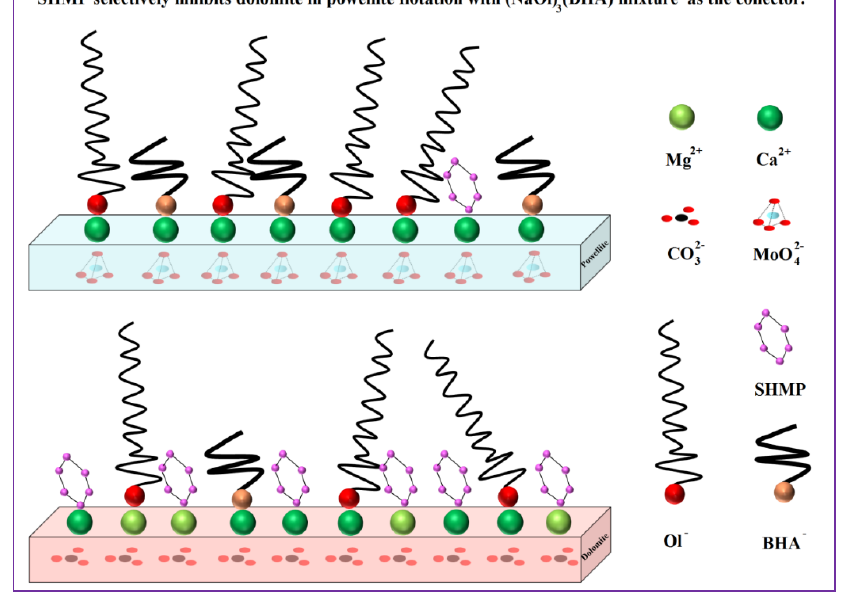
Figure 9. Schematic diagram of the selective depression mechanism of SHMP for the flotation of powellite from dolomite with mixed NaOl/BHA collector (condition: 25 × 10 − 5 M SHMP; 15 × 10 − 5 M NaOl; and 5 × 10 − 5 M BHA; pH 9–10).